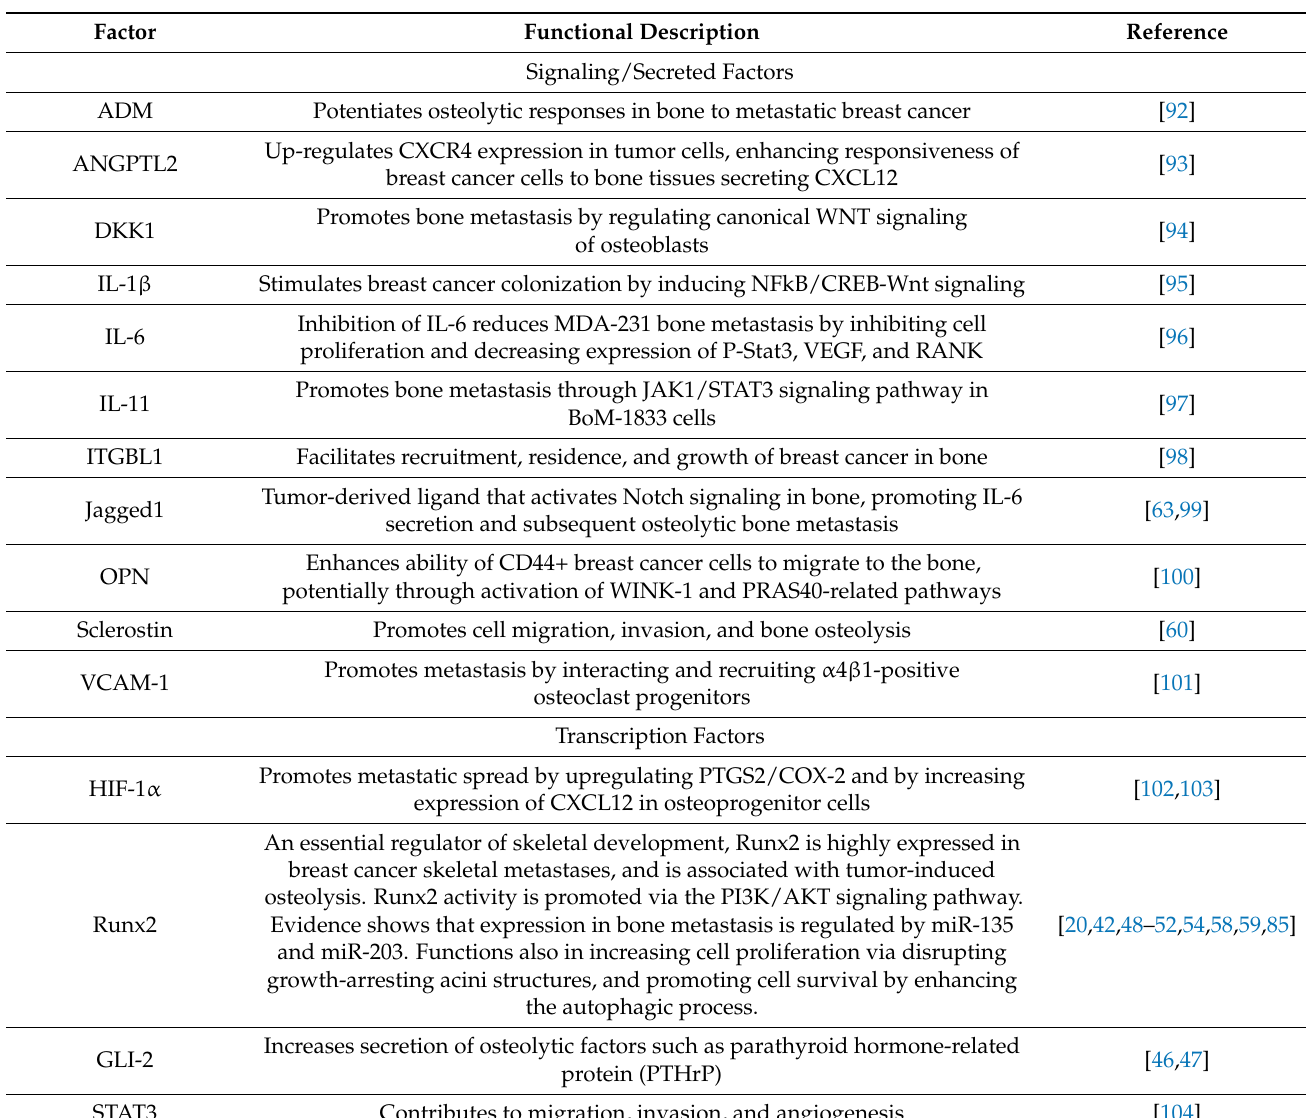
Table 1. Factors contributing to bone